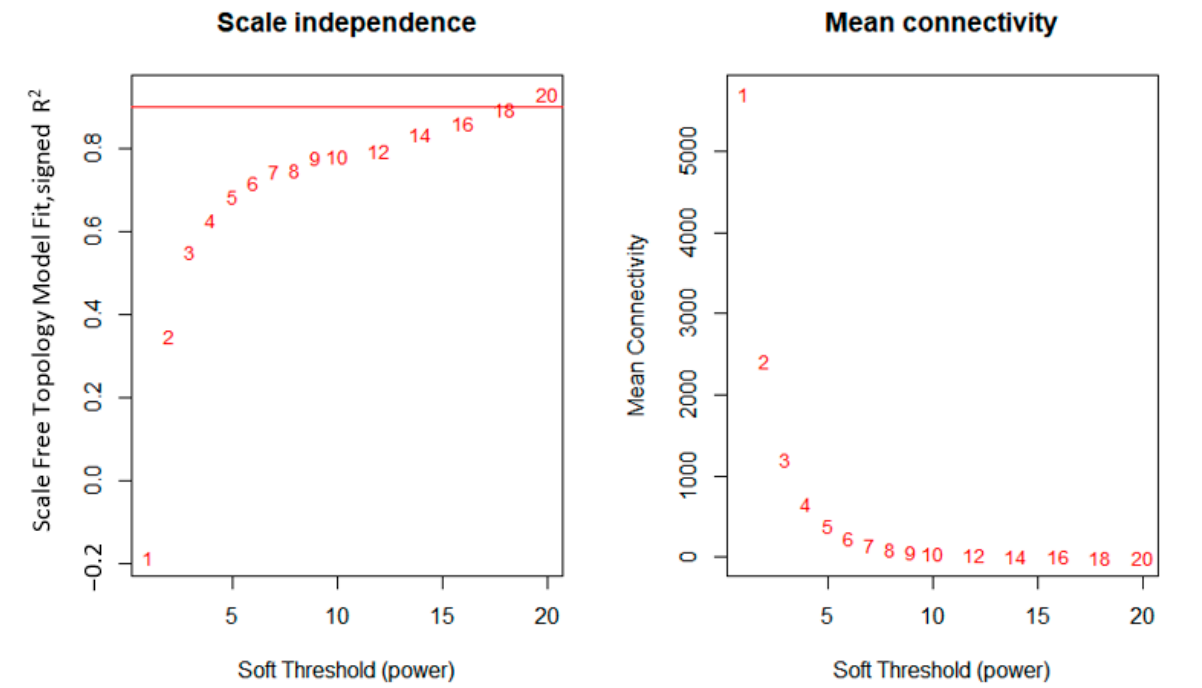
Figure 2. Results of determination of soft threshold power to ensure scale-free topology ( left ) and the summary of mean connectivity score at each threshold ( right ).